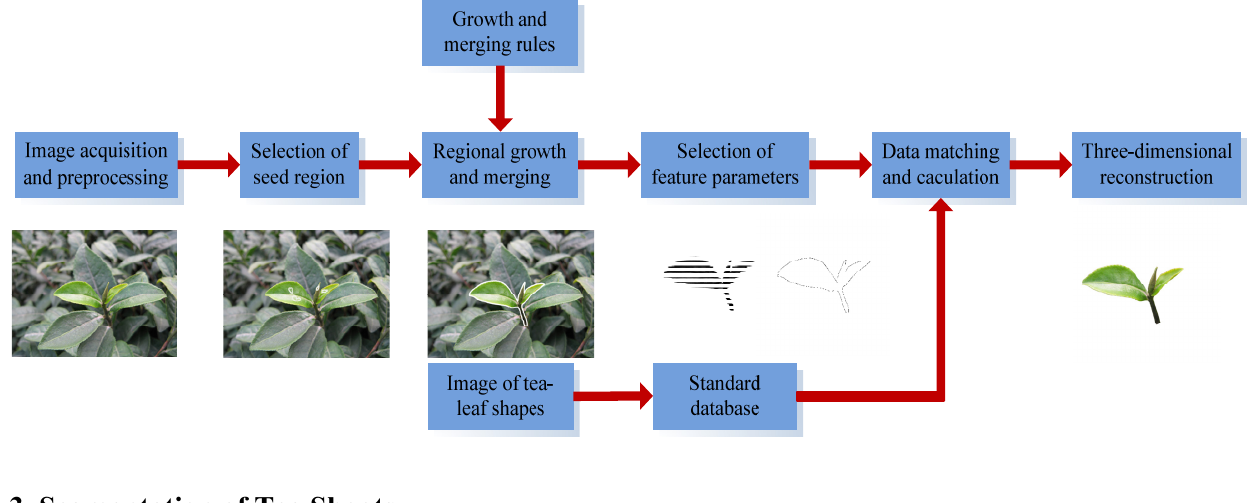
Figure 1. Overview of the tea-shoot modeling